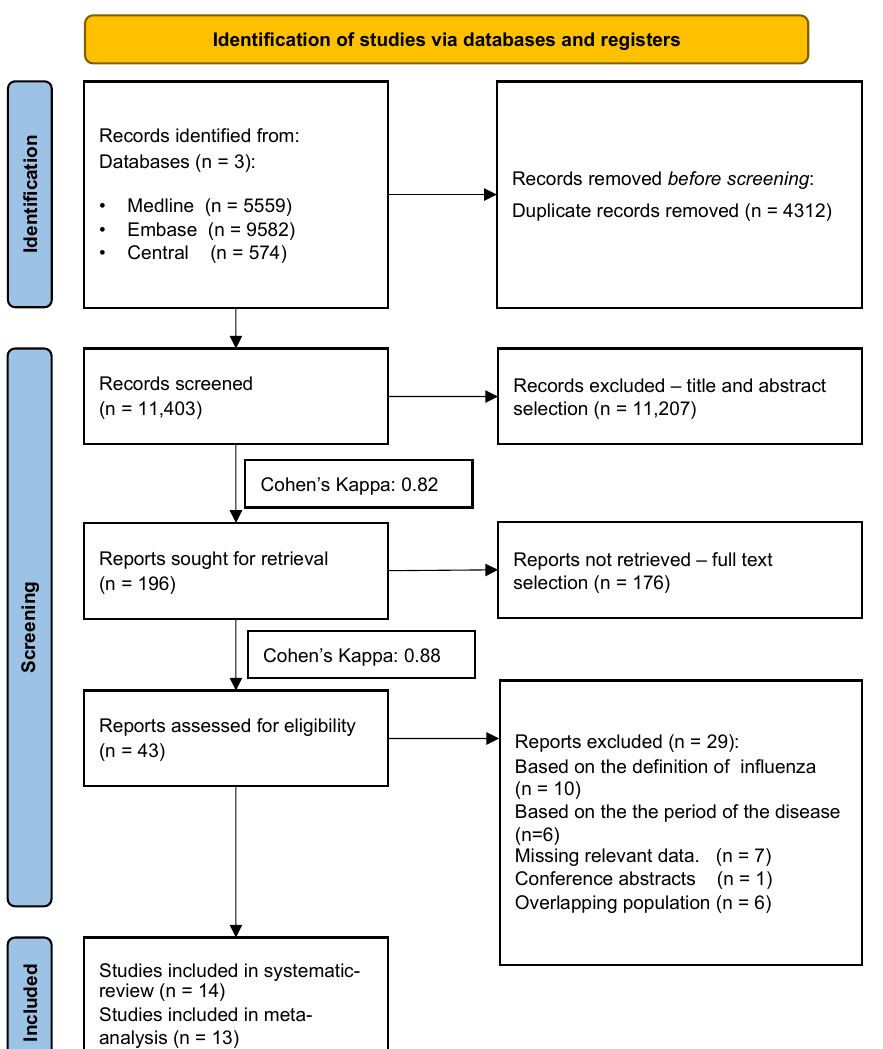
Figure 1. Flowchart of the systematic search and